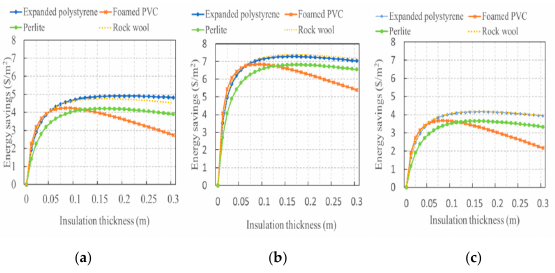
Figure 5. Lifetime energy savings versus thickness of insulating materials for three typical walls. ( a ) Clay brick wall. ( b ) Hollow concrete block wall. ( c ) Fly ash block wall. 3.2. Annual Cost of Heating versus Insulation Thickness for Different Insulating Materials Figure 6 shows the total cost of the fuel and insulating materials used in three walls. The relationship between the insulation cost and thickness is a linear relationship. It can be noted from these figures that the total cost was correlated with the cost of insulating